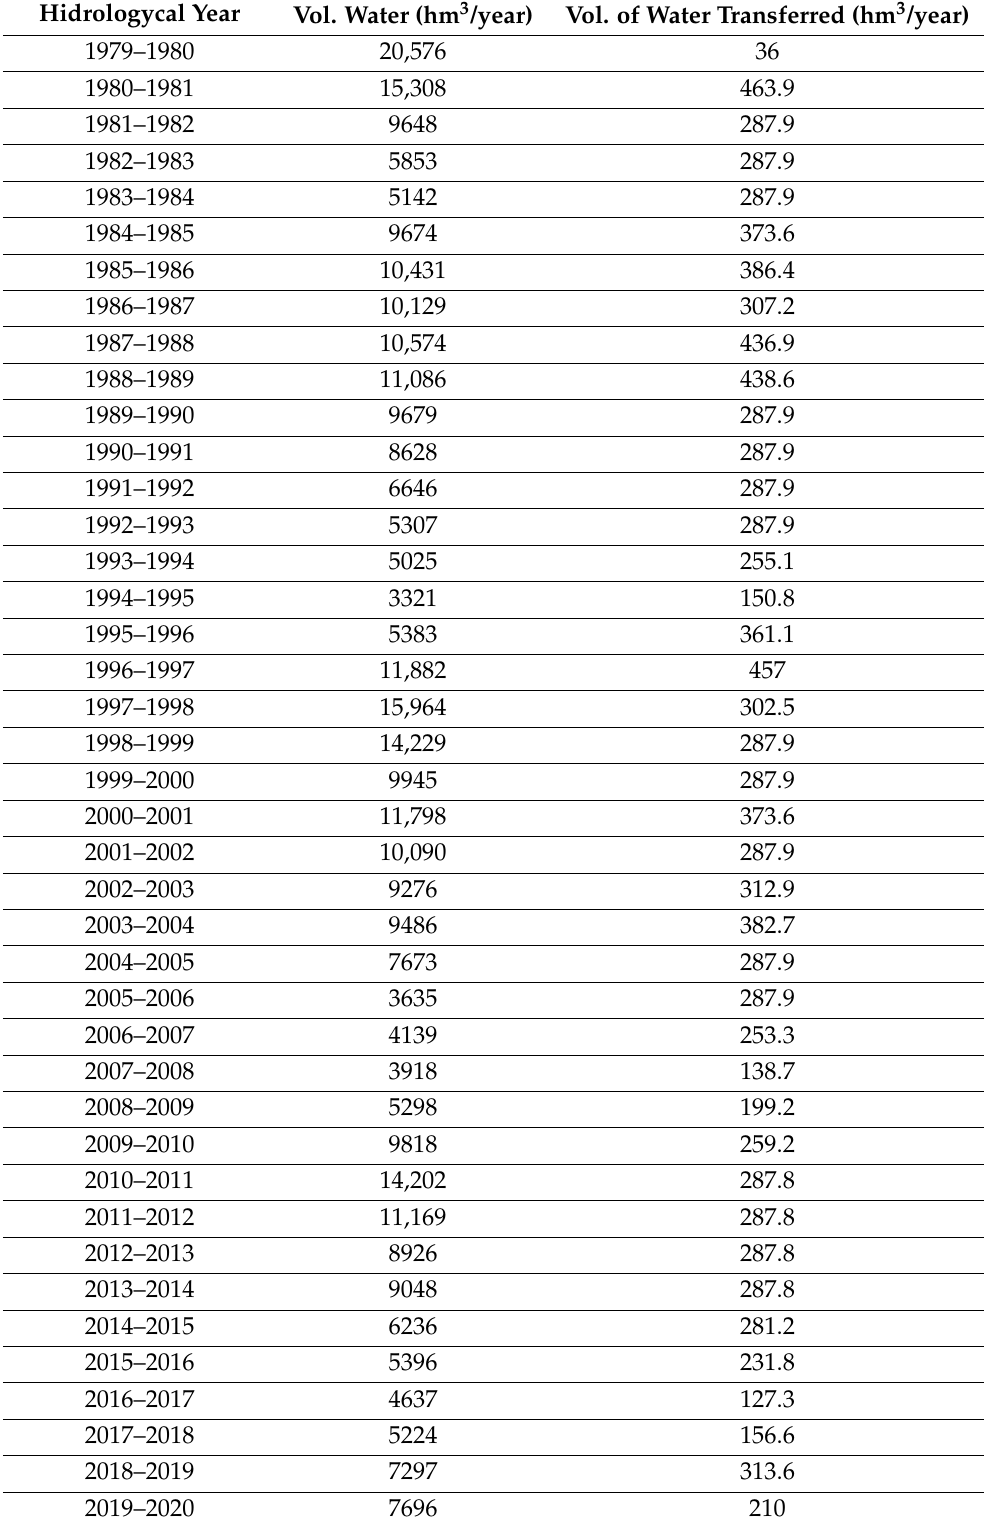
Table 4. Comparison between water stored in the Entrepeñas–Buend í a reservoir and volumes of water transferred by the Tagus–Segura